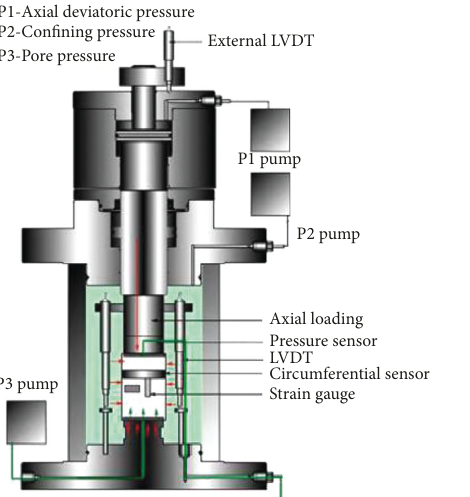
Figure 4: The strain-time map of sandstone subjected to thermal damage ( σ 3 � 3MPa, T � 600 °